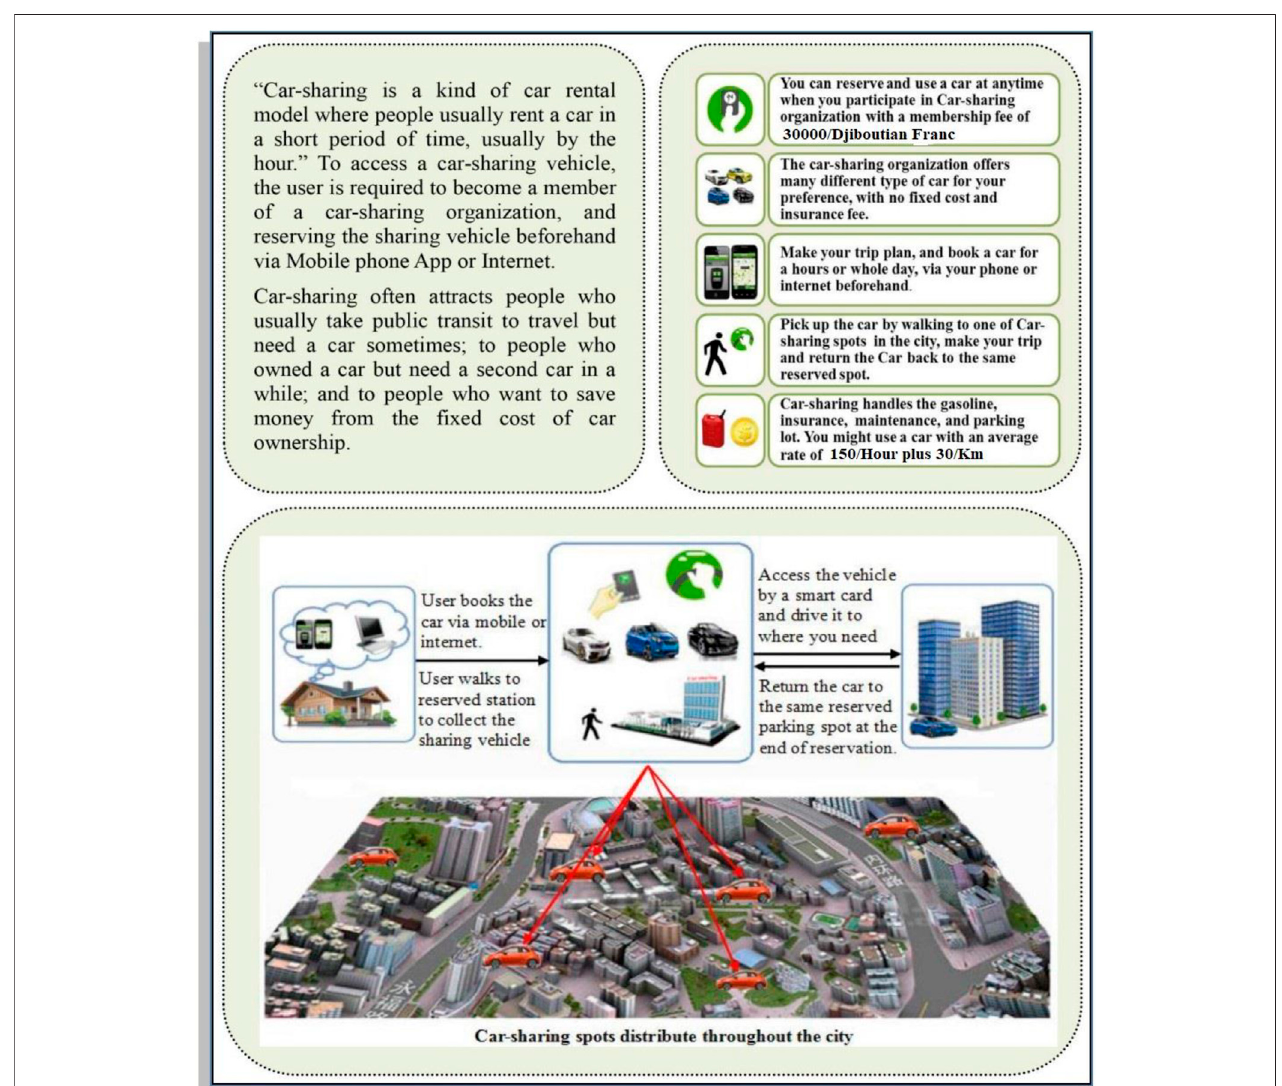
FIGURE 1 | Car sharing brochure (Ullah et al.,